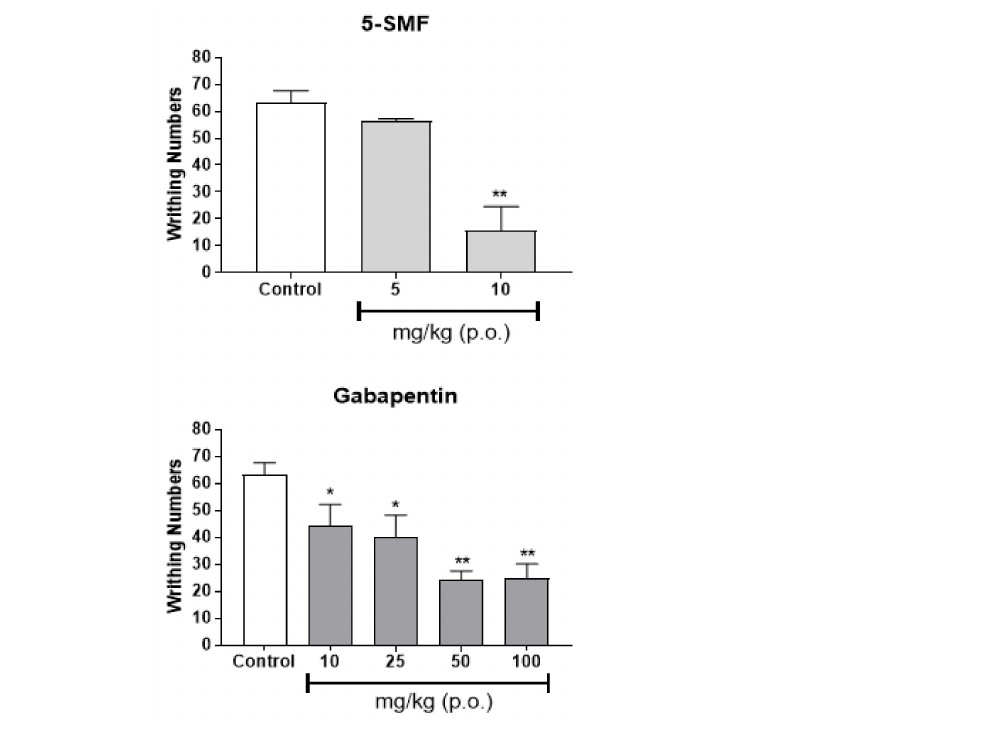
Figure 12. Effect of 5-SMF and gabapentin in the acetic acid-induced abdominal writhing test. Data are expressed as mean ± SD; n = 4 mice per group. (* p < 0.05, ** p < 0.001 vs. control group).